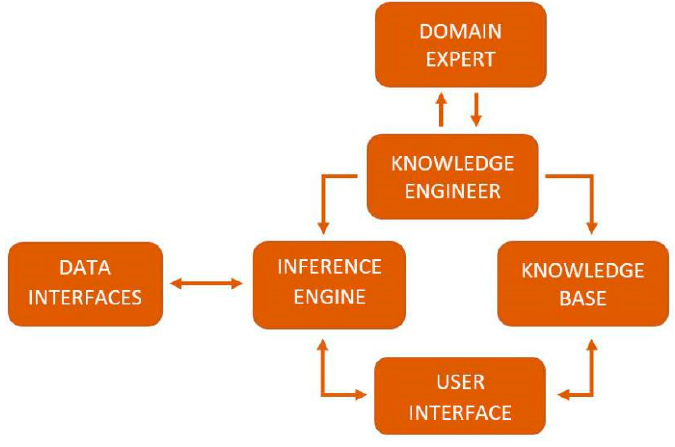
Figure 6. The structure of expert systems and their integration (reproduced from [57]).